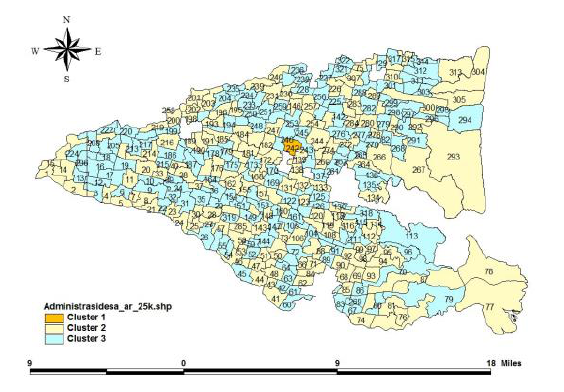
Figure 3: Health Sector Village